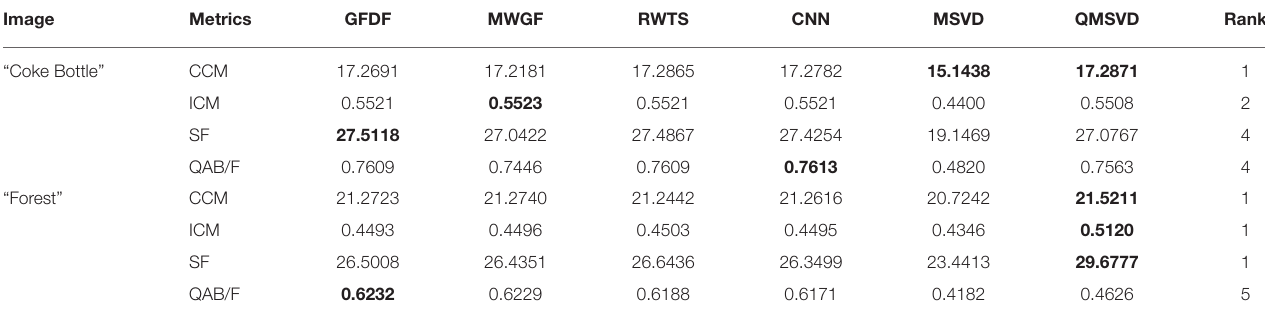
TABLE 4 | Objective evaluation metrics of multi-focus color images in Figures 8 , 9 .